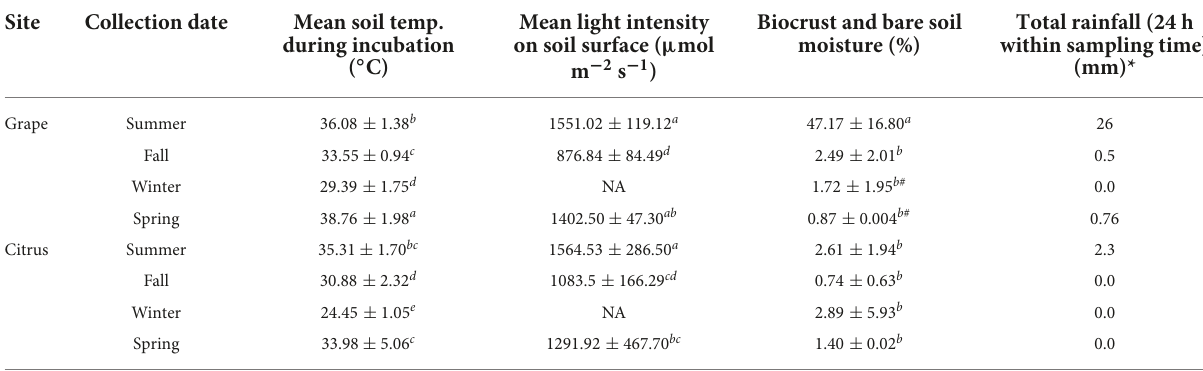
TABLE 3 Environmental parameters of field